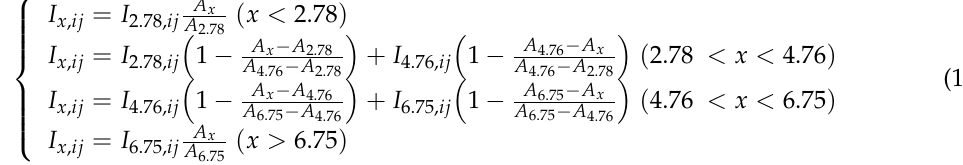
nozzles: 6.75, 4.76 and 2.78 mm, appearing from top to bottom respectively.